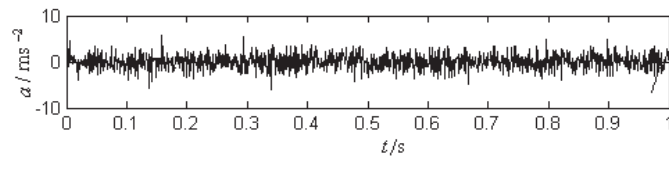
Fig. 1. The vibration acceleration signal of a normal